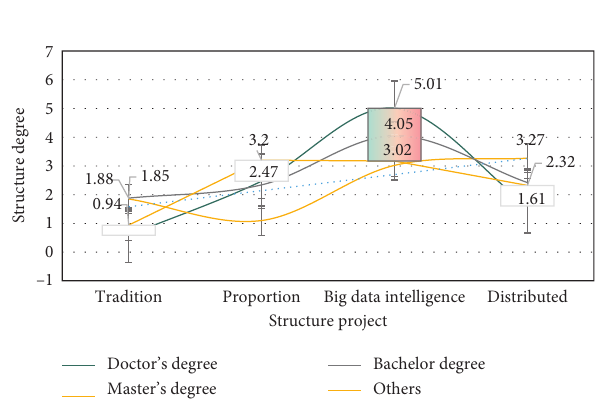
Figure 13: Education structure.